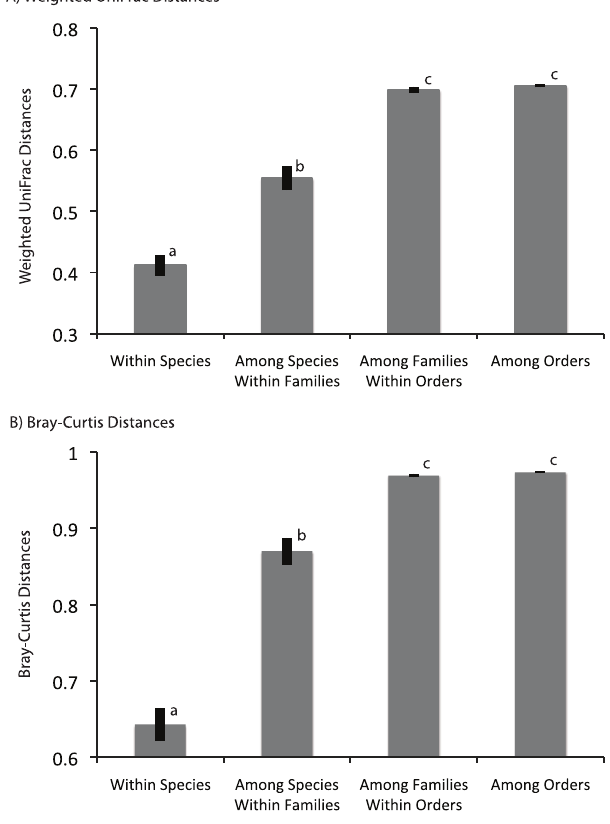
Figure 4. Effect of taxonomic classification on bacterial community dissimilarity. Average weighted UniFrac (A) and Bray- Curtis (B) dissimilarity values of bacterial communities from specimens within species, within families and among species, within orders and among families, and among orders. Error bars represent standard error.